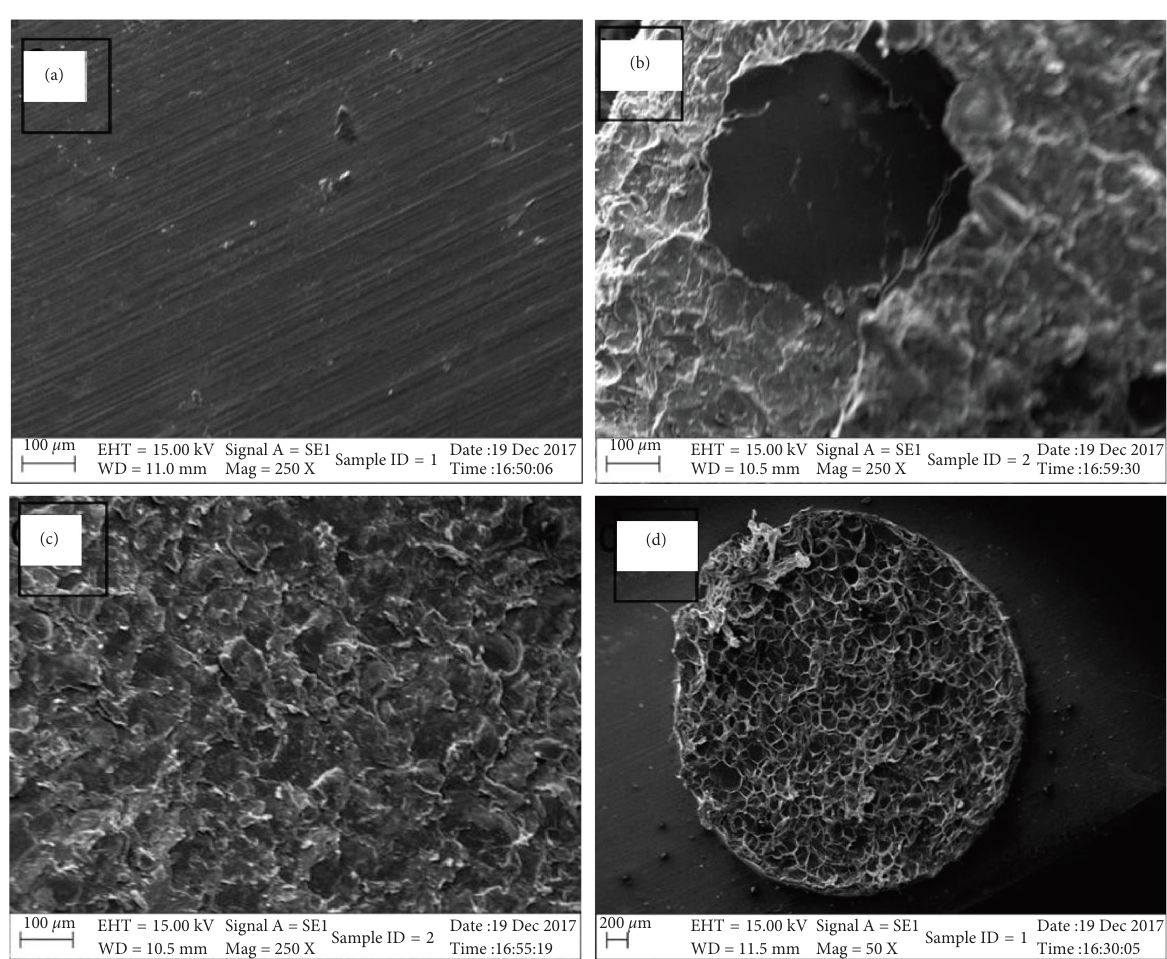
Figure 3: (a) Aluminium sheet with e-glass epoxy coated surface; (b) aluminium sheet with 5bar SS sandblasted and resin coated peeled surface; (c) peel surface with cured resin and coating; and (d) PET form compressed with a fully peeled surface.